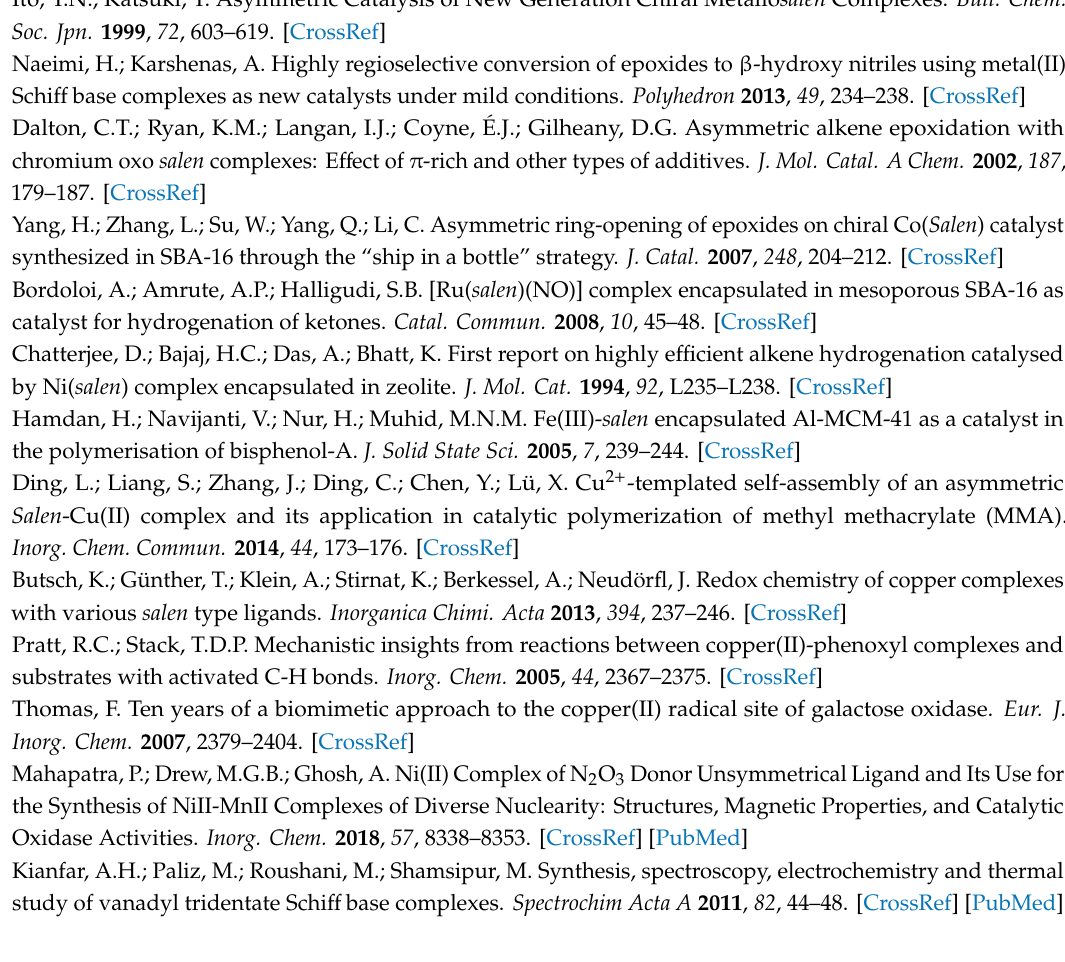
DMSO-d6. Figure S22. 13 C-NMR of NiMeO salen in DMSO-d6. Figure S23. 1 H-NMR of NiMe salen in chloroform. Figure S24. 13 C-NMR of NiMe salen in chloroform. Figure S25. 1 H-NMR of NiOH salen in DMSO-d6. Figure S26. 13 C-NMR of NiOH salen in DMSO-d6. Figure S27. 1 H-NMR of Ni salen in chloroform. Figure S28. 13 C-NMR of Ni salen in chloroform. Figure S29. COSY spectrum of Ni salen in chloroform. Figure S30. HSQC spectrum of Ni salen in choloform. Figure S31. 1 H-NMR of NaCl salen in chloroform. Figure S32. 1 H-NMR of NiBr salen in chloroform. Figure S33. 1 H-NMR of NiNO 2 salen in DMSO-d6. Figure S34. 1 H-NMR of NiOH salphen in DMF-d7. Figure S35. 13 C-NMR of NiOH salphen in DMF-d7. Figure S36. COSY spectrum of NiOH salphen in DMF-d7. Figure S37. HSQC spectrum of NiOH salphen in DMF-d7. Figure S38. 1 H-NMR of NiMeO salphen in CDCl 3 . Figure S39. COSY spectrum of NiMeO salphen in CDCl 3 . Figure S40. Voltammogram of NiMeO salen 1 mM in DMSO. Figure S41. Voltammogram of NiMe salen 1 mM in DMSO. Figure S42. Voltammogram of NiOH salen 1 mM in DMSO. Figure S43. Voltammogram of Ni salen 1 mM in DMSO. Figure S44. Voltammogram of NiCl salen 1 mM in DMSO. Figure S45. Voltammogram of NiBr salen 1 mM in DMSO. Figure S46. Voltammogram of NiNO 2 salen 1 mM in